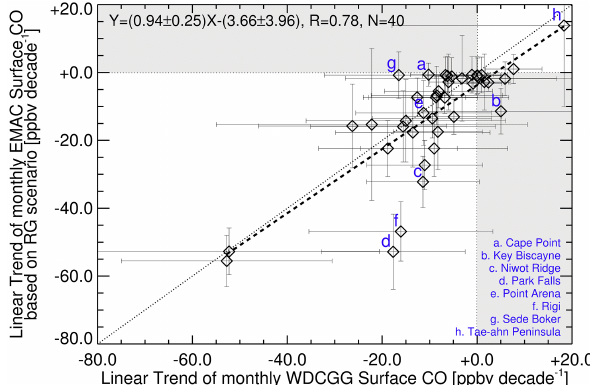
Figure 7. As in Fig. 6b but for the trends of monthly EMAC- simulated surface CO from a model grid box oriented towards the upwind direction at the stations.